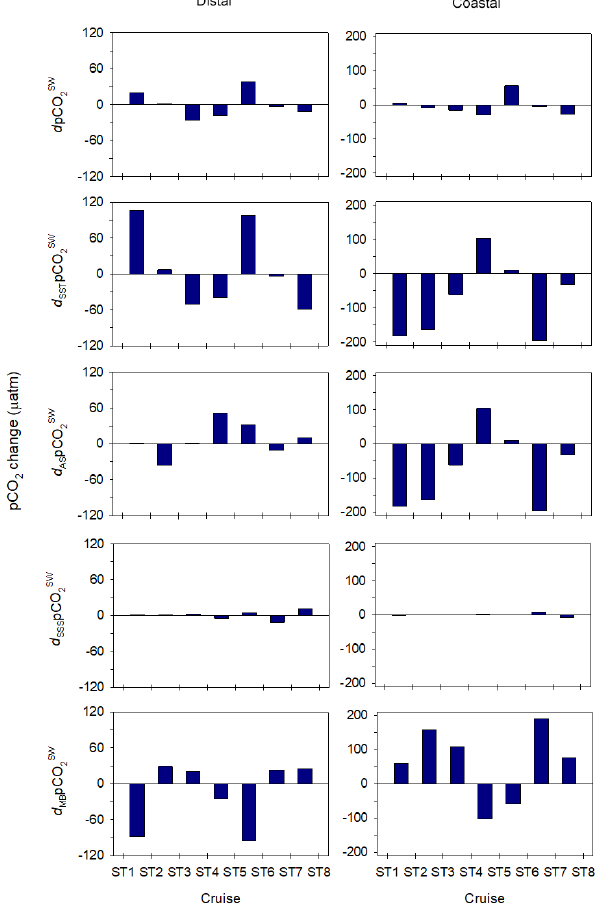
Figure 6. Observed changes in p CO 2 (first row) and p CO 2 changes broken down due to SST changes (second row), air–sea CO 2 ex- change (third row), SSS changes (fourth row), and biology plus mixing (last row) in the distal (left column) and coastal areas (right column) between the periods of each cruise: ST1 (March 2014), ST2 (June 2014), ST3 (October 2014), ST4 (December 2014), ST5 (March 2015), ST6 (June 2015), ST7 (September 2015) and ST8 (February 2016).